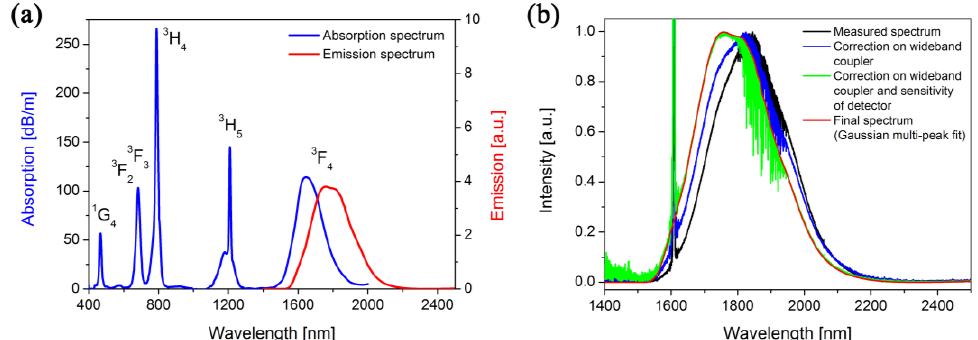
Figure 5. ( a ) Measured optical absorption and emission spectra of prepared optical fiber SD with the indication of the corresponding absorption and emission energy levels. ( b ) Optical emission spectrum of optical fiber SD as measured on our FTIR spectrometer together with the spectrum of correction on spectral characteristics of wideband coupler as well as correction on the sensitivity of the detector; also the final spectrum (with eliminated pump peak at 1611 nm and absorption peaks due to the water absorption) is